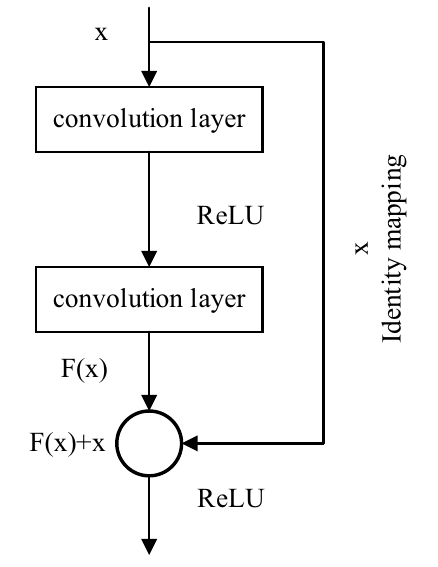
Fig. 3 The structure of the residual